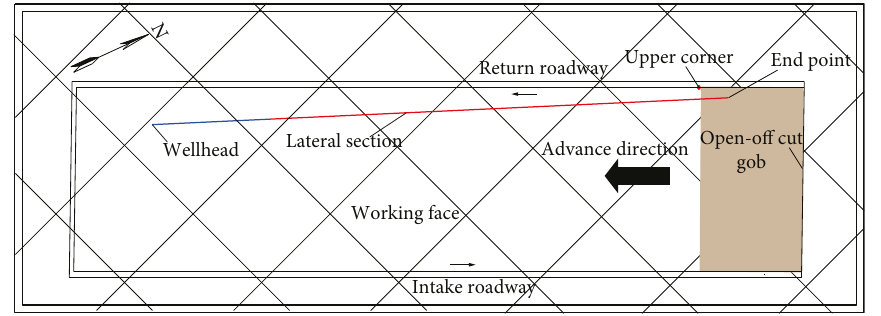
Figure 3: Layout of the working face.